Question: In one sentence, what is this figure communicating?
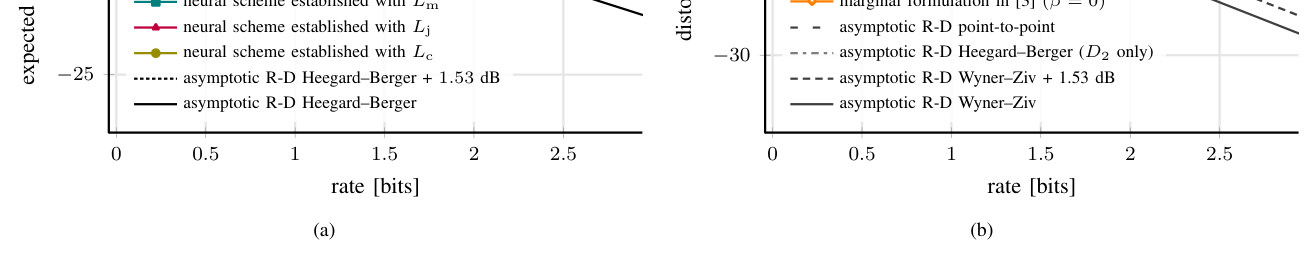
Answer: Rate–distortion (R-D) performances obtained with joint, marginal and conditional formulations (see Eqs. (13), (14) and (15)), where experimental setup parameters (see Section II-B) are set as σ2 x = 1.00, σ2 n = 0.10 and β = 0.01. In both panels, we plot the empirical results versus the asymptotic bounds. We provide the expected distortion achieved by two decoders (see Fig. 2) in the left panel, while we only plot the distortion attained by the informed decoder, which has access to side information, in the right panel. The 1.53 dB refers to the mean-squared error gap that the entropy-constrained one-shot lattice quantizer is subjected to in high-rate regime [19].